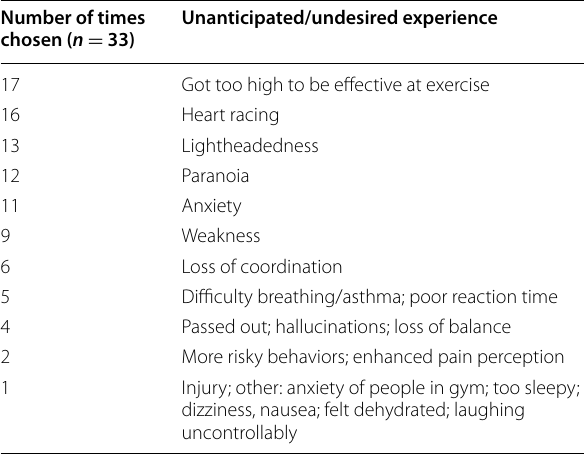
Table 4 Unanticipated/undesired experiences while exercising with cannabis